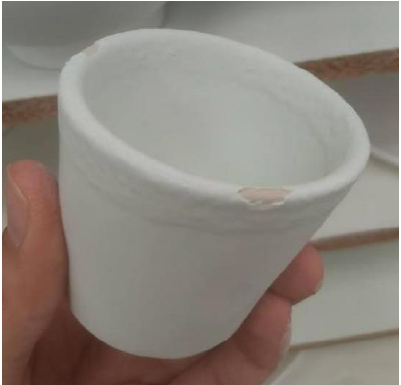
Figure 2. Example of defect in small absences in glazed or glazed chipped.